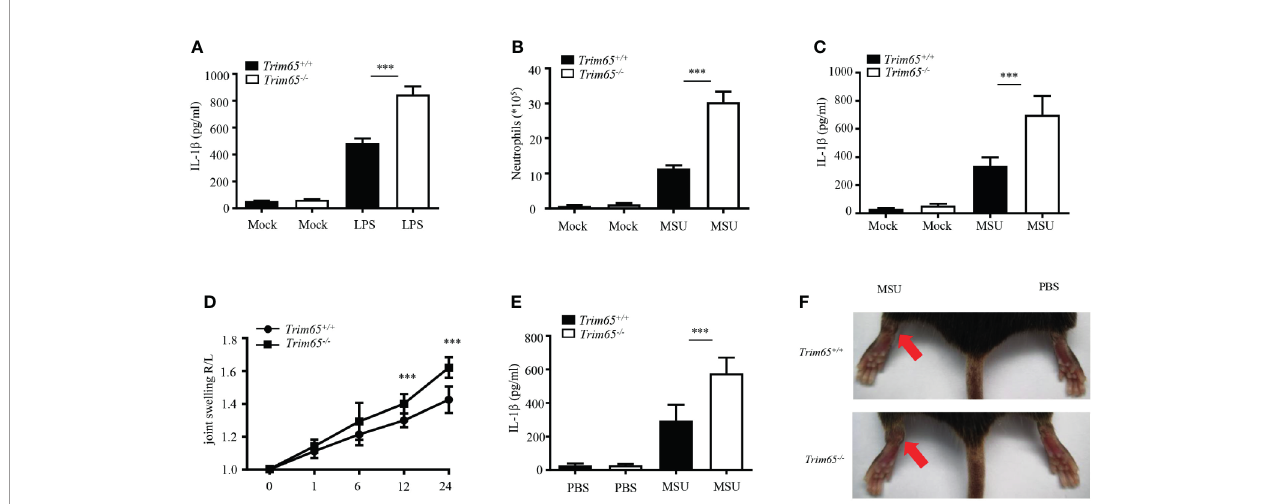
FIGURE 5 | TRIM65 signaling prevents LPS-induced systemic in fl ammation and MSU-induced peritonitis and gouty arthritis via suppression of the NLRP3 in fl ammasome. (A) Wild-type or Trim65 -/- mice (5 mice per group) were intraperitoneally injected with LPS (15 mg/kg) and treated for 4.5 h. The sera were collected, and the levels of IL-1 b were measured by ELISA. (B, C) Wild-type or Trim65 -/- mice (4-5 mice per group) were intraperitoneally injected with MSU crystals (1 mg/ mouse) and treated for 6h. The numbers of neutrophils in the peritoneal cavity were analyzed by FACS (B) , and the levels of IL-1 b (C) were assayed by ELISA. (D – F) Wild-type or Trim65 -/- mice (7-10 mice per group) were intraperitoneally injected with MSU crystals, after which joint swelling (D) at different time points was measured with a Vernier caliper, the levels of IL-1 b (E) in the supernatants of joint cultures at 24 h were assayed by ELISA, and changes in joint swelling at 24 h were compared (F) . Data are shown as the means ± SEM of two or three independent experiments. Student ’ s t -test, *** P <